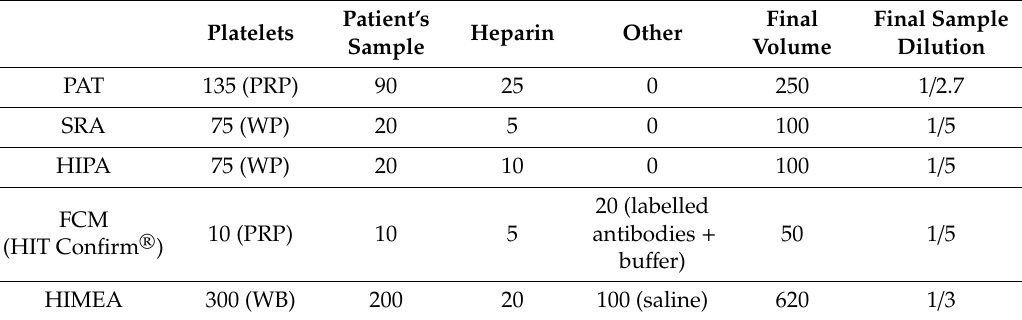
Table 2. Most frequent volumes ( µ L) of components used in HIT functional